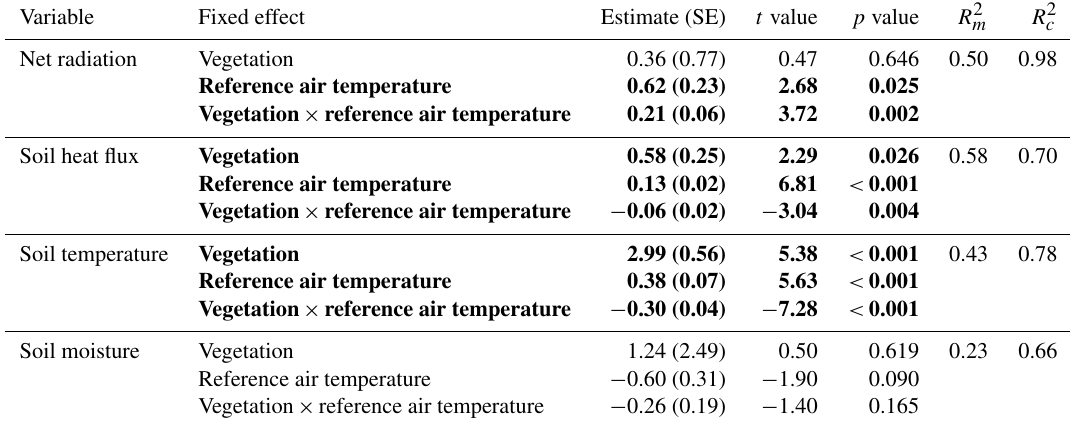
Table 2. Results of the linear mixed models for the effect of vegetation type and air temperature on the daily total net radiation, the daily total soil heat flux, the daily average soil temperature and the daily average soil moisture. Statistically significant effects ( p< 0 . 05) are indicated in bold. R 2 m indicates the variation explained by the fixed effects, and R 2 c indicates the variation explained by the entire model. See Fig. 5 for a visualization of the models. The results of the linear mixed models for daytime and nighttime are reported in Appendix